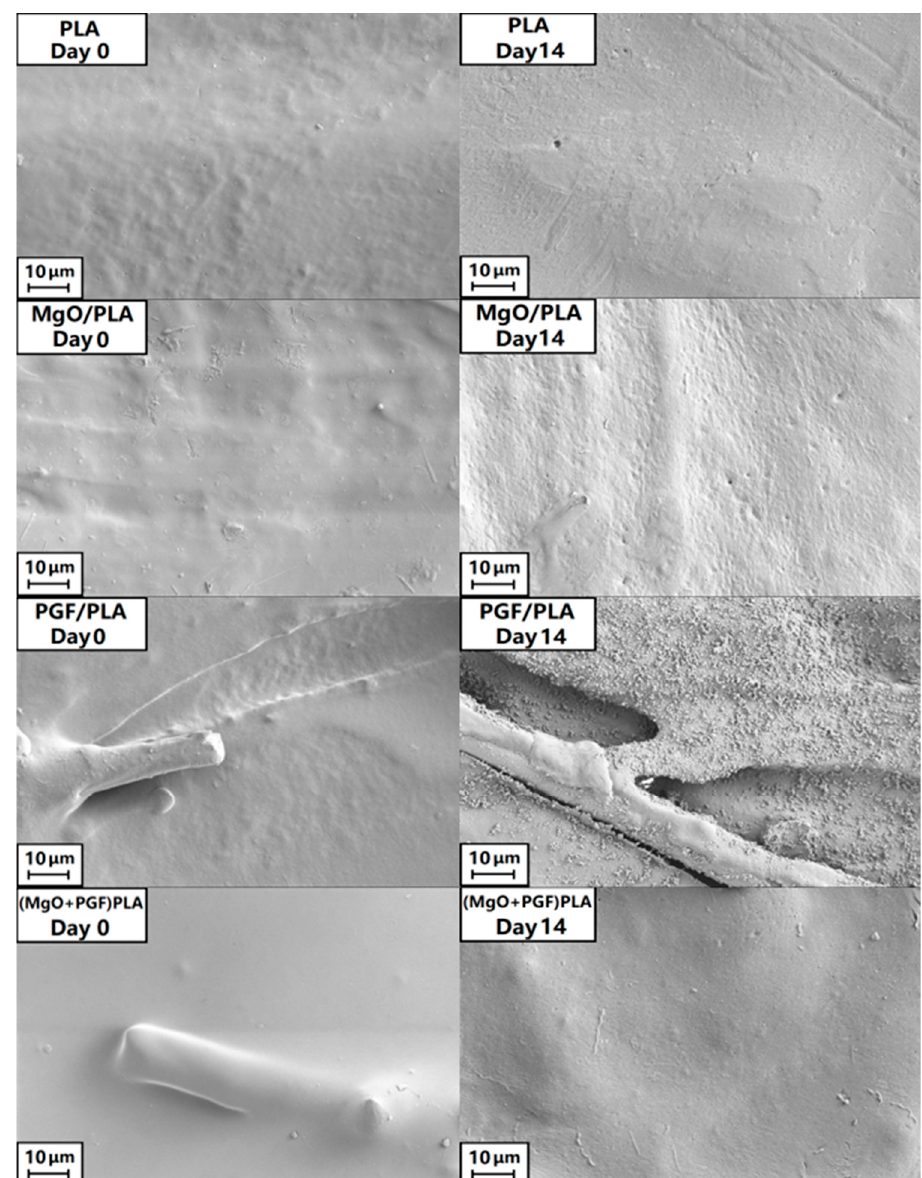
Figure 7. SEM image of the top surface of different scaffolds before and after 14 days of in vitro degradation in Tris-HCl under 37 °C.